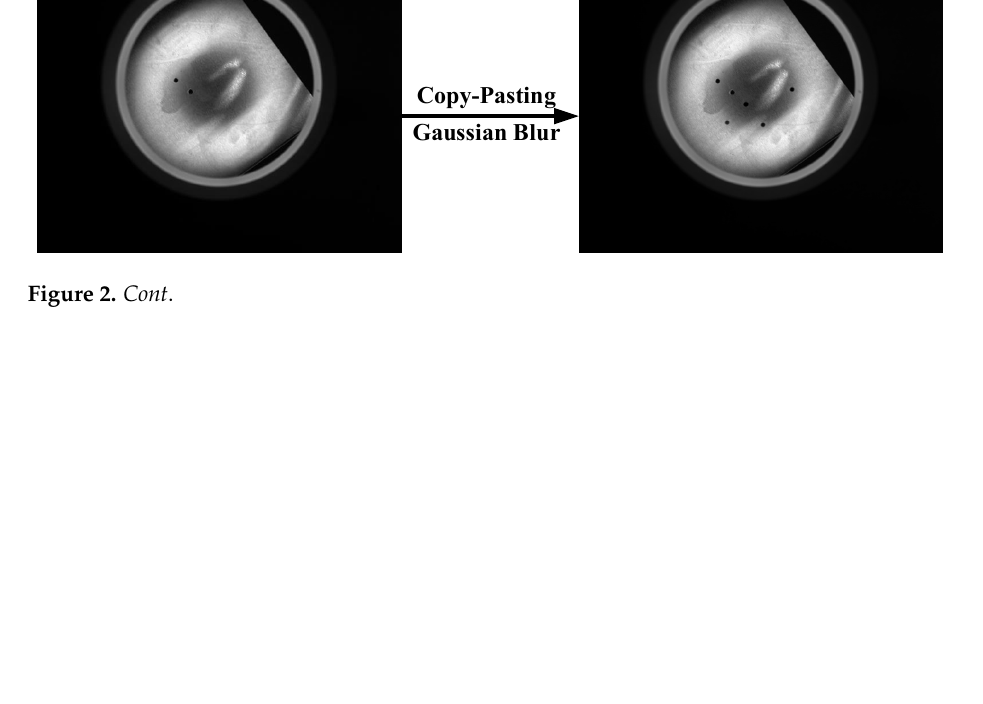
Copy-Pasting Copy-Pasting Gaussian Blur